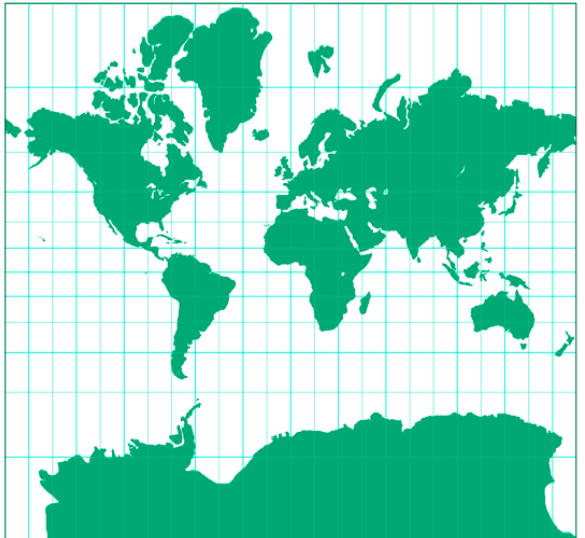
Figure 7. The Mercator projection is a cylindrical map projection with straight and perpendicular meridians and parallels. It preserves the angles at all latitudes and therefore it is widely used for navigation purposes. A resulting disadvantage is the linear scale distortion towards the higher latitudes and the resulting misleading appearance of areas [26] (By Tobias Jung [CC BY-SA 4.0 (http://creativecommons.org/licenses/by-sa/4.0)], via kartenprojektionen.de).